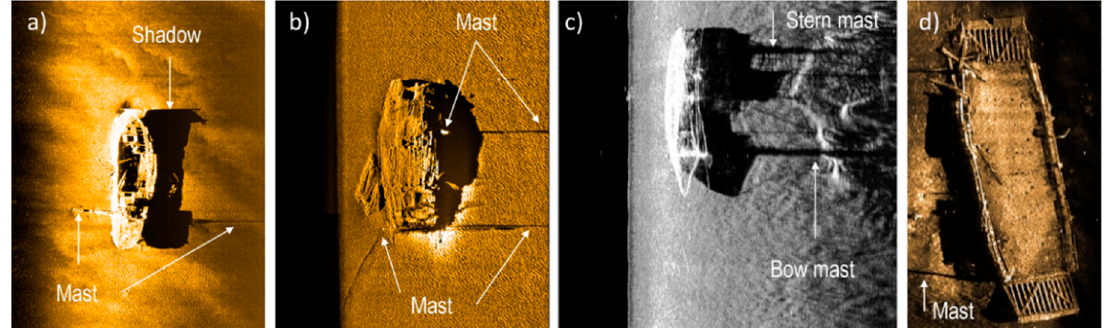
Figure 11. Examples of the wrecks with protruding, vertical structural elements. ( a ) yacht wreck; ( b ) barge with piles of wood; ( c ) fishing boat; and ( d ) barge.